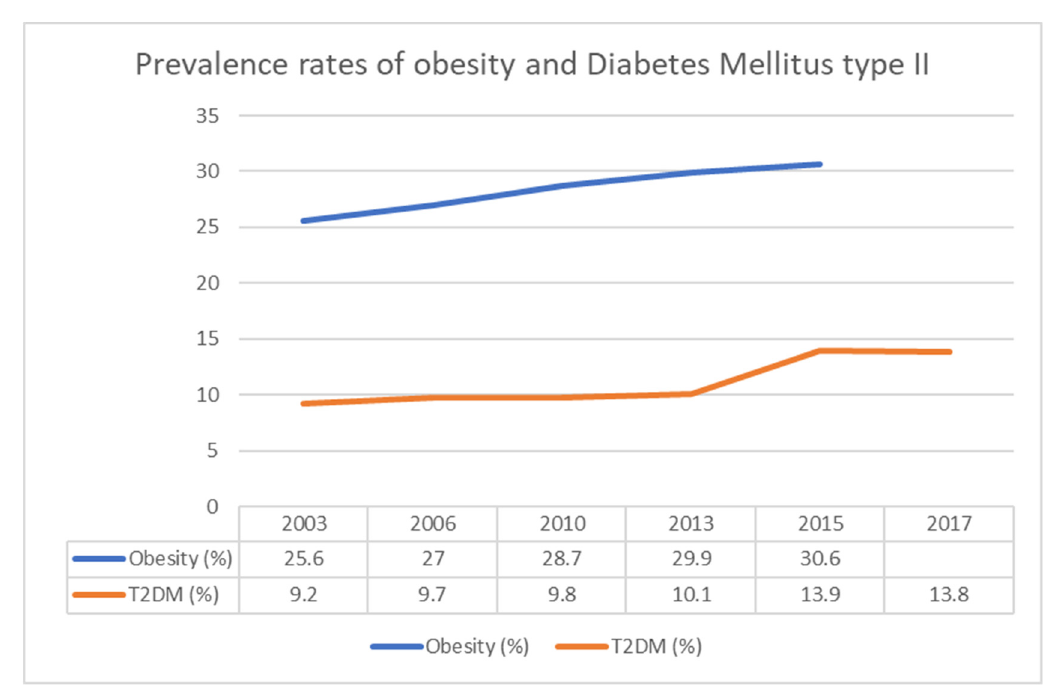
Figure 1. Percentage incidence of obesity and diabetes in the Maltese islands over the years.